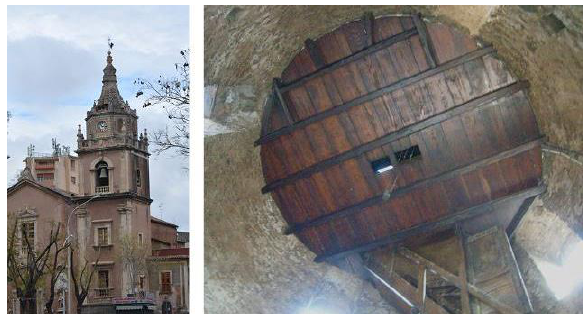
Figure 1. The bell tower of Sant’Agata al Borgo in Catania. On the right, the floor under the cusp.